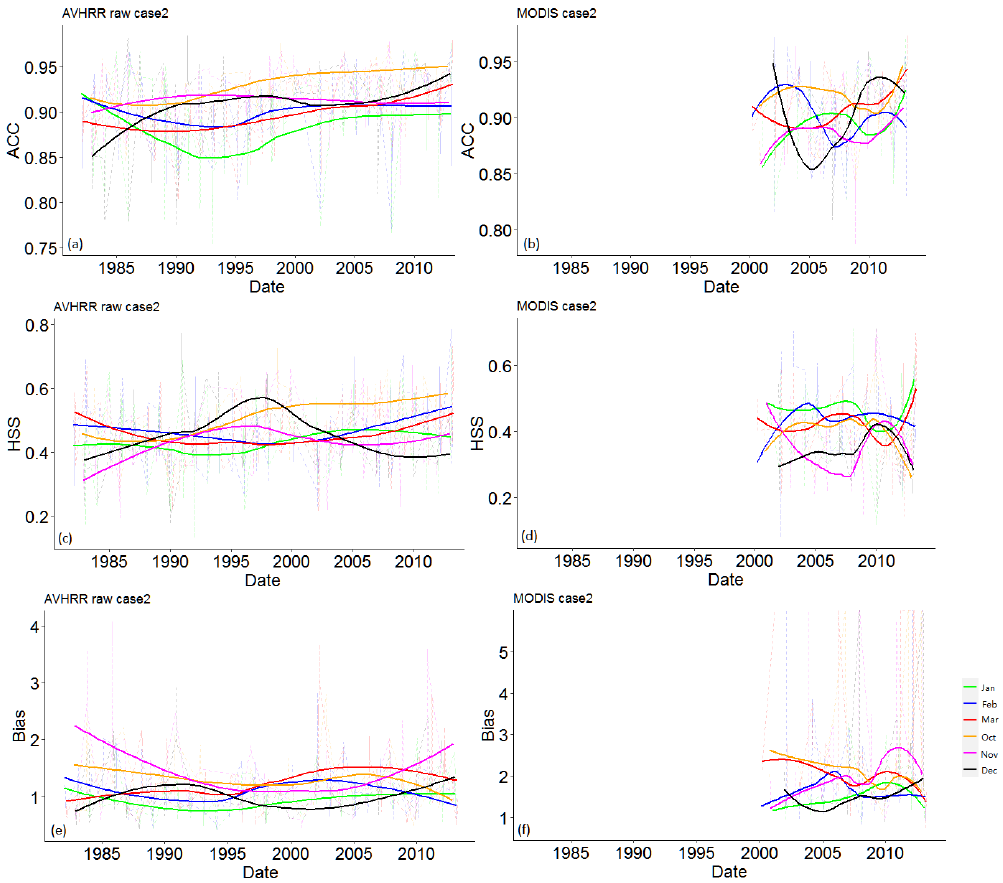
Figure 5. The temporal behavior of ACC for AVHRR raw and MODIS snow data in different months (indicated by the different colored lines) during the snow season. The solid-colored lines represent the fitted trend of these accuracy indicators for different